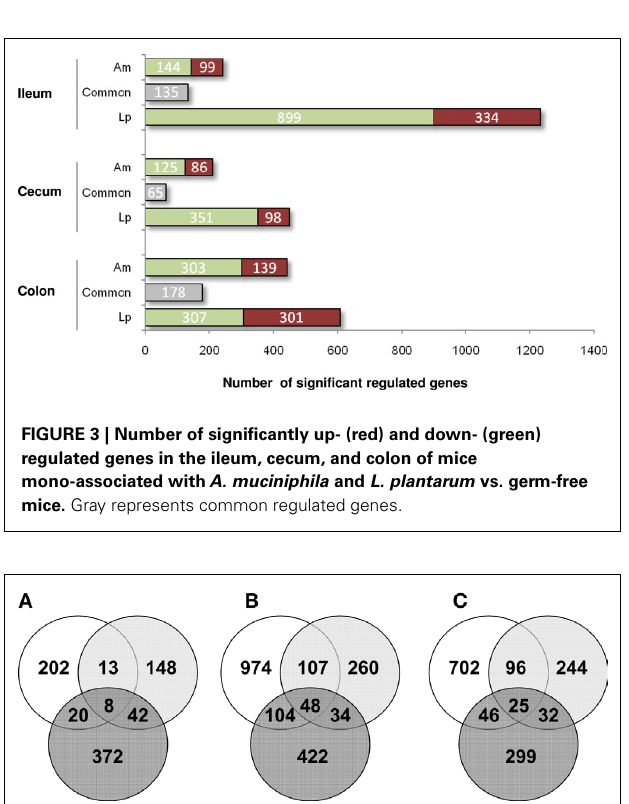
FIGURE 4 |Venn diagrams representing the number of common significantly regulated genes in the ileum (white), cecum (light gray), and colon (dark gray) of mice mono-associated with A. muciniphila (A) and L. plantarum (B) interaction compared to germ-free mice data and L. plantarum compared to A. muciniphila data (C).